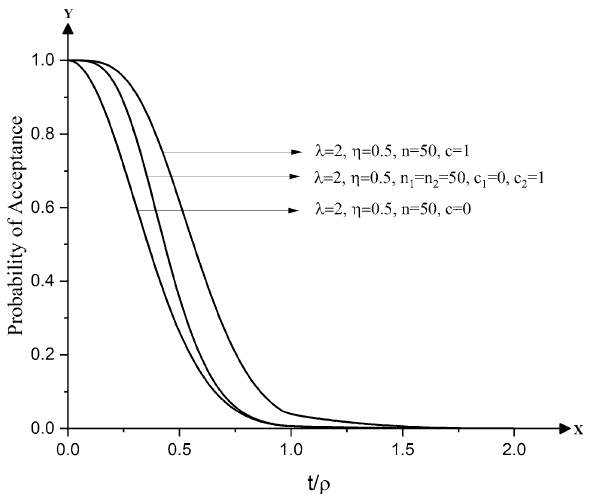
Figure 1. Operating characteristic curves of single and double sampling plans for life tests based on Pareto type IV distribution having smaller values of acceptance